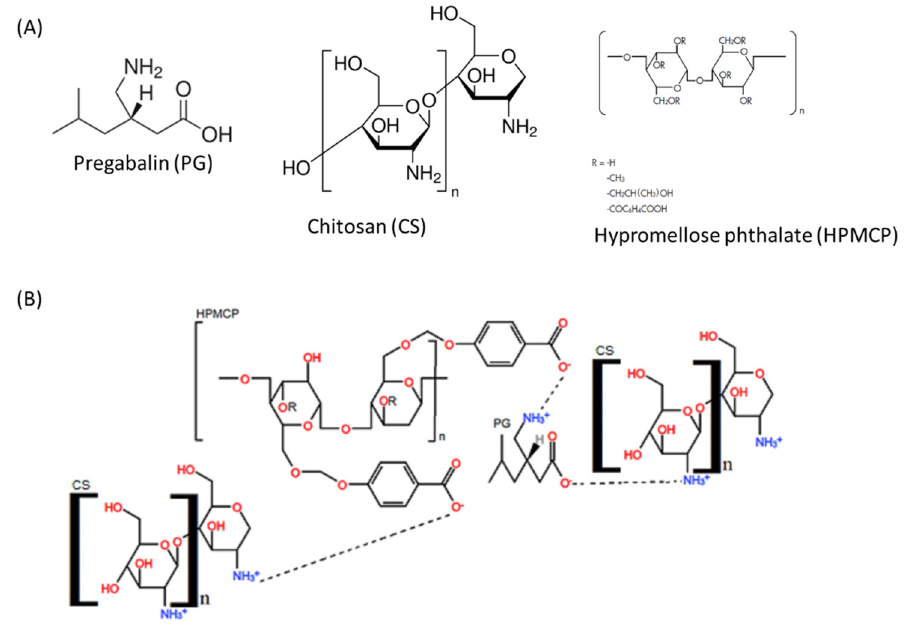
Figure 7. ( A ) Structural formula of pregabalin, chitosan, and hypromellose phthalate. ( B ) Possible interaction between the polymers and pregabalin.